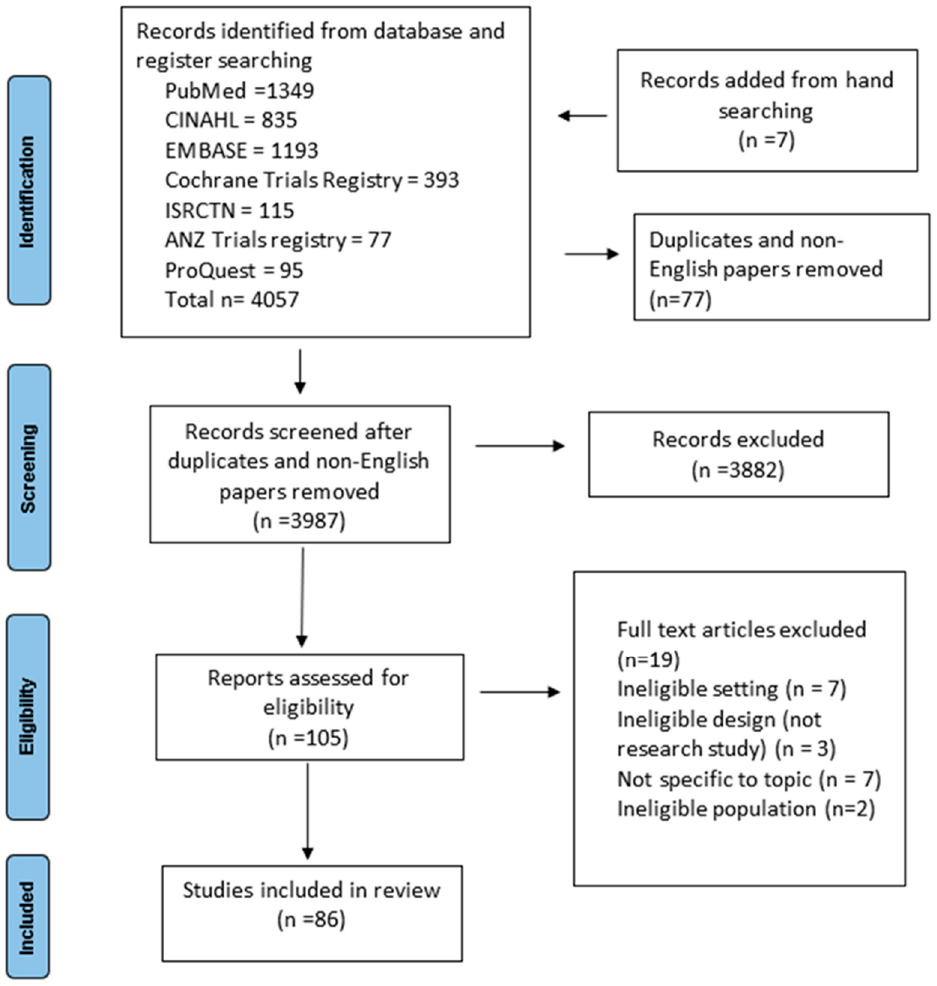
Figure 1. PRISMA flowchart of the study selection and inclusion process [15].